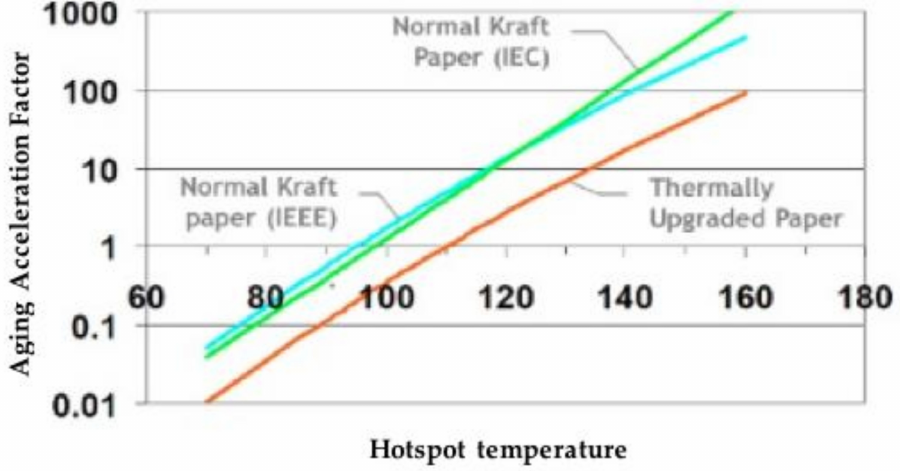
Figure 2. WHT vs. ageing acceleration factor